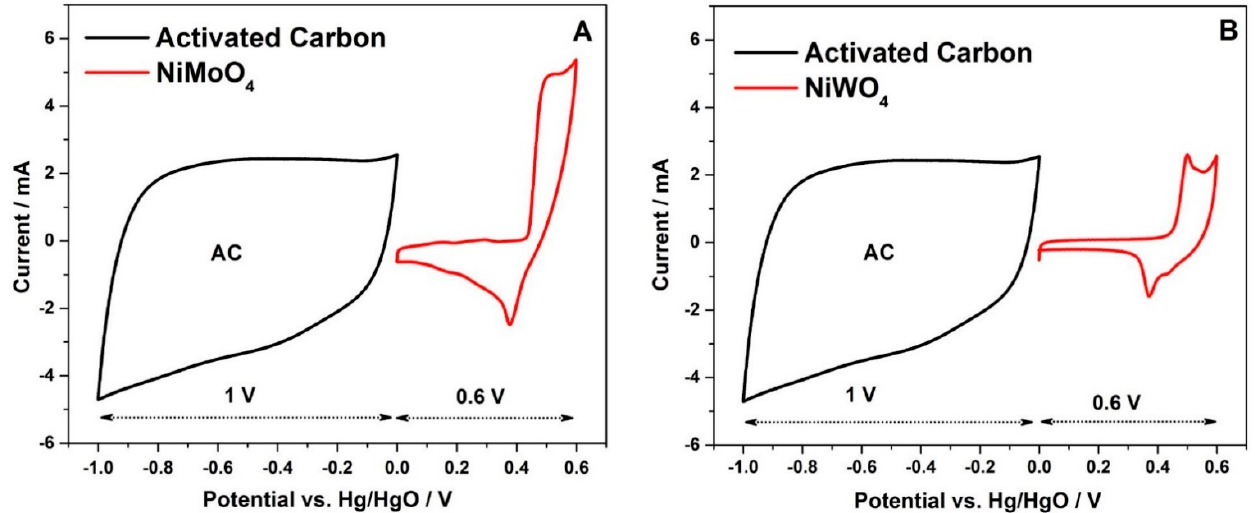
Figure 10. ( A , B ) Cyclic voltammetric curves of NiMoO 4 and NiWO 4 along with activated carbon (AC) recorded in a three-electrode configuration with Hg/HgO as the reference electrode.